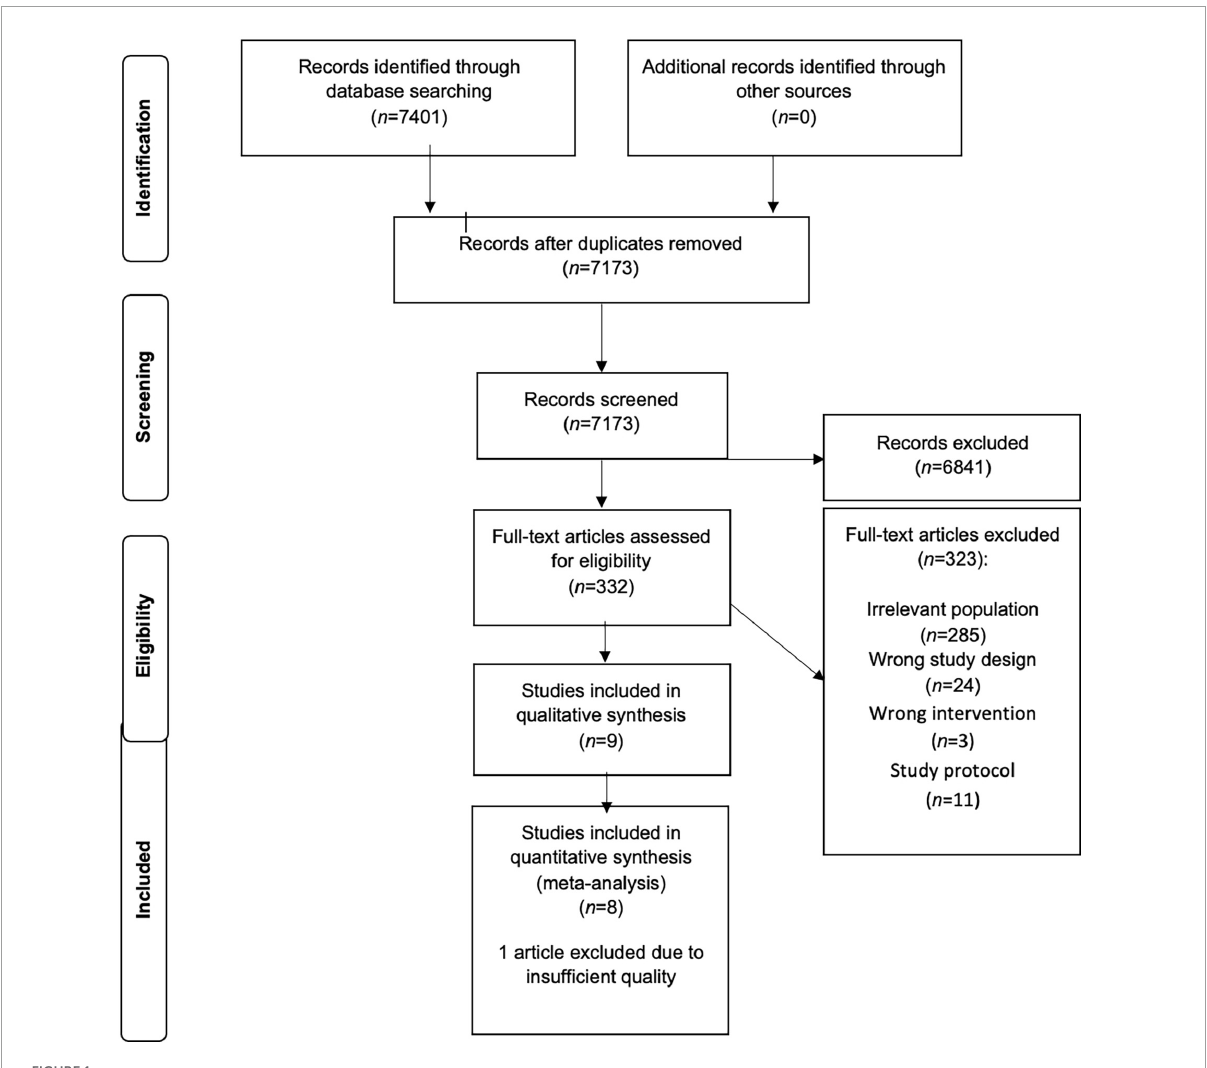
FIGURE1 PRISMA flow